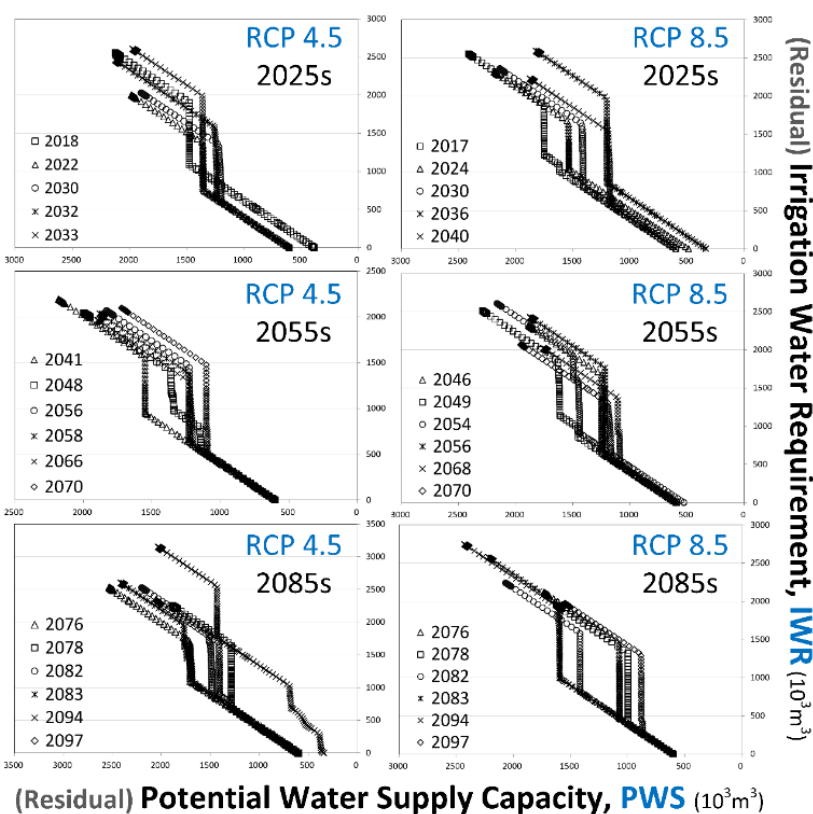
Figure 8. Distribution changes in the irrigation water requirement and the potential water supply capacity as determined by the drought year during the future period in the agricultural reservoirs of the central region: Res. A.